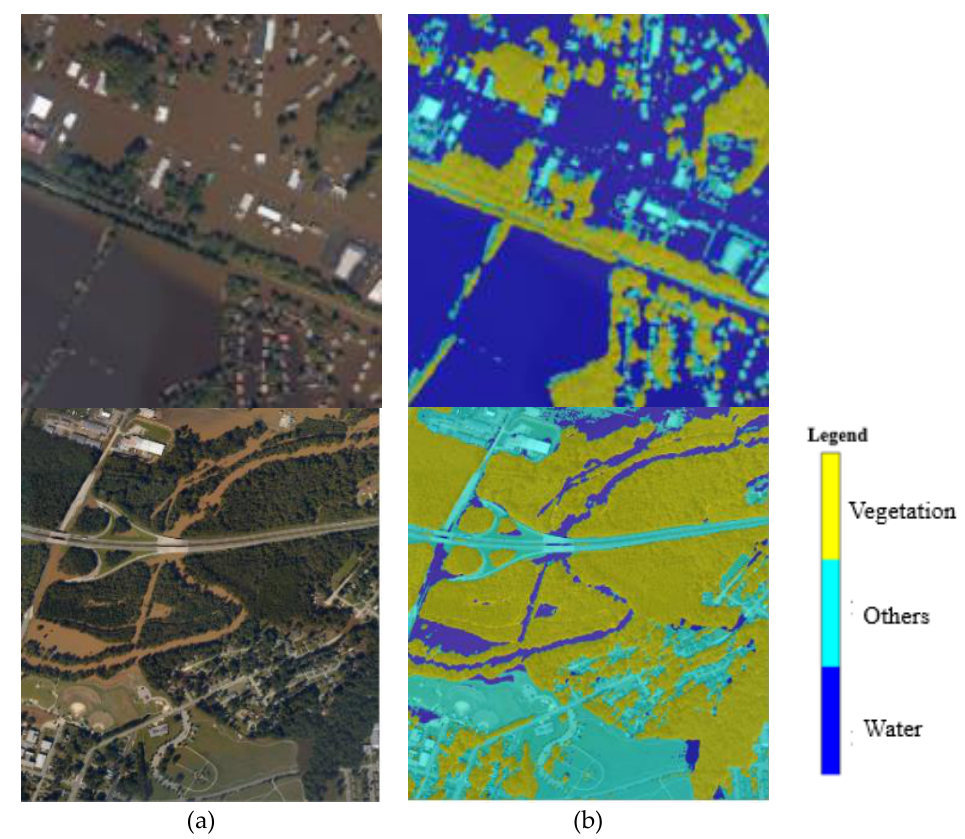
Figure 4. Two sample FCN-8s) results. ( a ) Input aircraft images acquired during Hurricane Matthew in Lumberton, NC in Oct 2016; ( b ) classification results. Table 1. Confusion matrix of FCN-8s (unit: percentage).